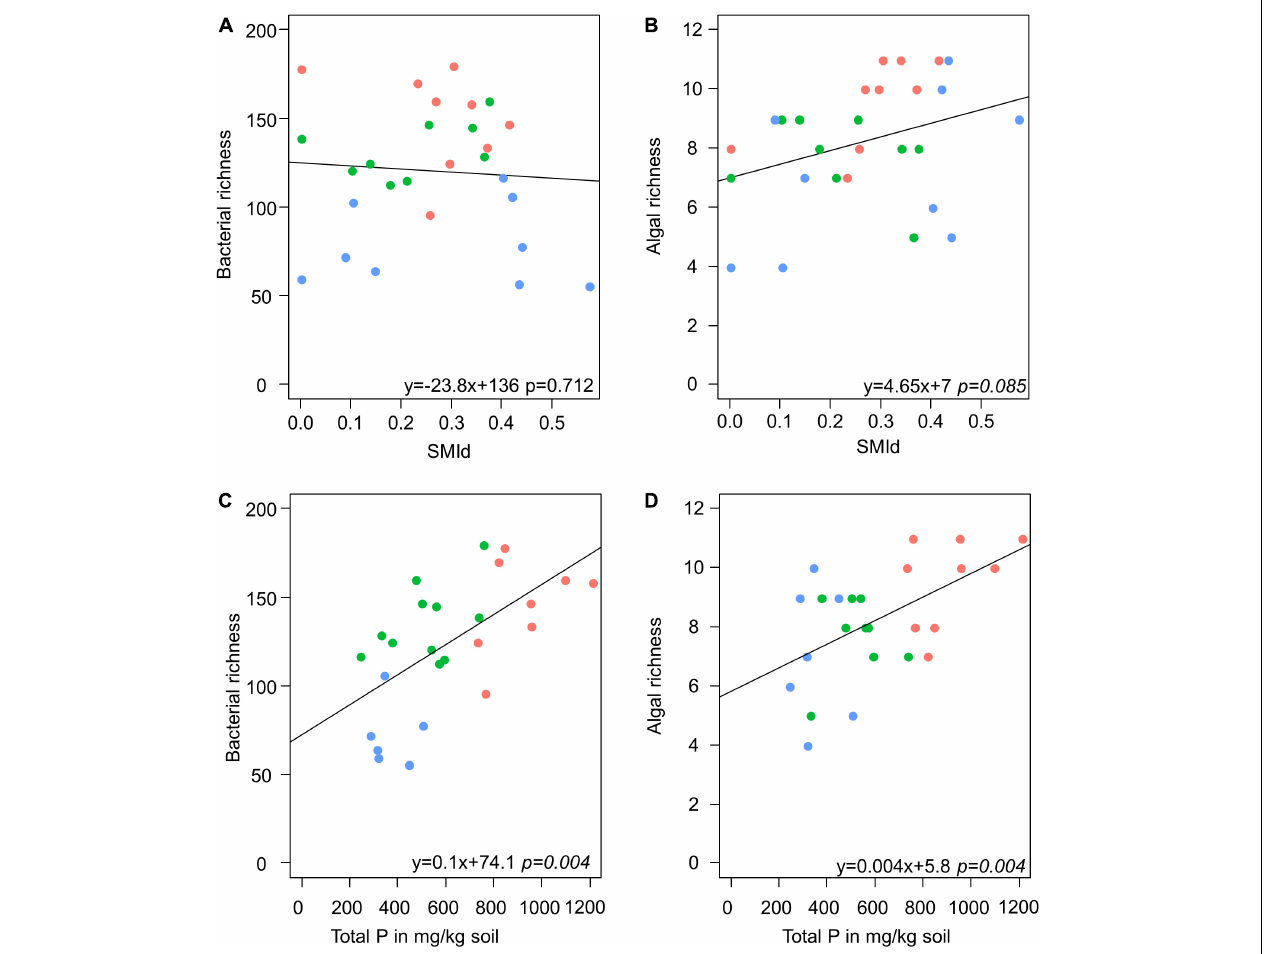
FIGURE 5 | Scatter plots visualize the correlation of stand density (as SMId—see Materials and Methods) with richness of bacteria (A) and alga (B) and the correlation of total P with richness of bacteria (C) and alga (D) in biocrusts. Red: Alb; green: Hainich; blue: Schorfheide. The results of a linear model are given below.